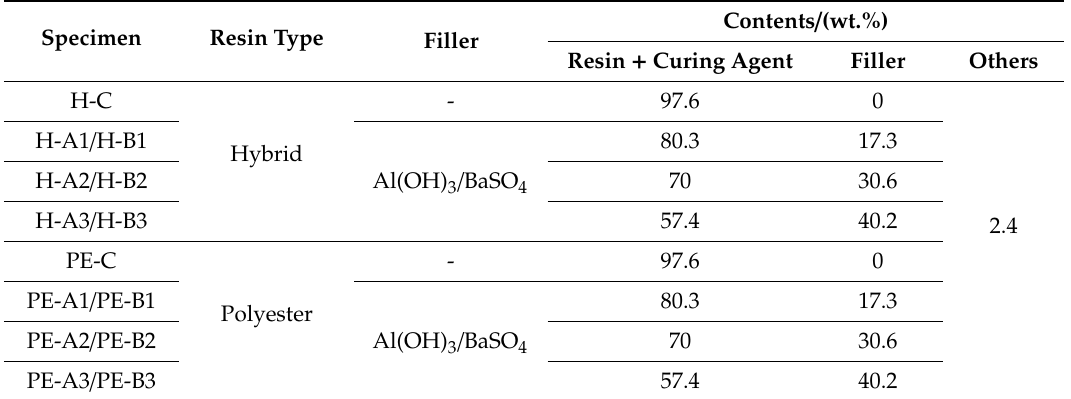
Table 2. Formulations of powder paints.